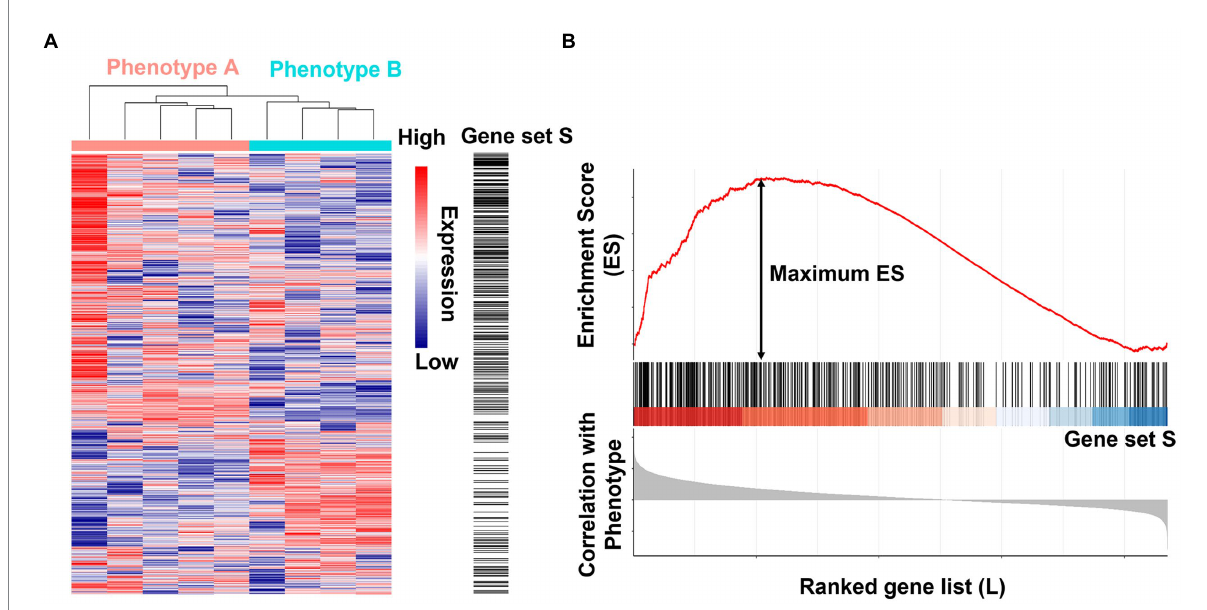
FIGURE 4 Illustration of the gene set enrichment analysis (GSEA) method. (A) A gene expression dataset sorted by correlation with phenotype, the corresponding heatmap, and the “gene tags,” i.e., location of genes from a set S within the sorted list. (B) Plot of the running sum for S in the data set, including the location of the maximum enrichment score (ES) and the leading-edge subset. The figures were drawn using data from GSE35958, only used to show the principle of GSEA